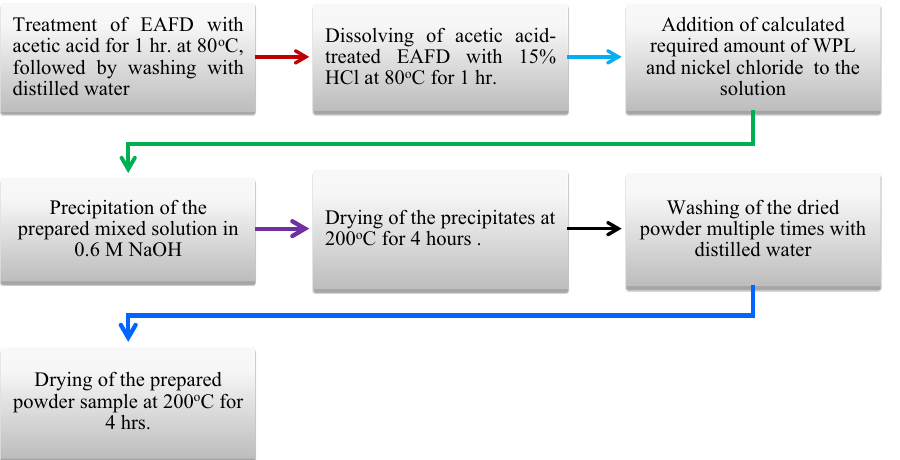
Figure 1. Flow chart of NZF preparation using EAFD and